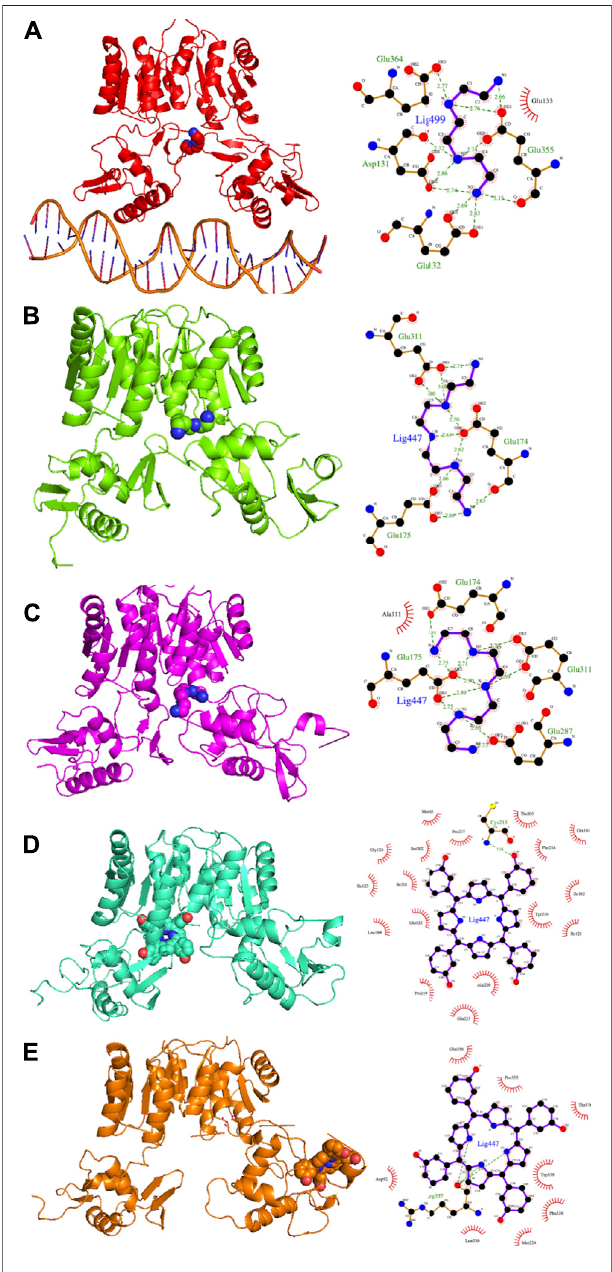
FIGURE 9 | Candidate drugs binding mode obtained from MD and interaction analysis. MD representative conformation of HP1043_DNA – trientine (A) , HP1043 – tetraethylenpentamine_Aext (B) and P – P (C) , HP1043_termopor fi n Aext (D) and Bi (E) and related Ligplot sketch of interaction analysis; dashed lines represent H-bonds and red eyelashes identify residues involved in hydrophobic contacts.